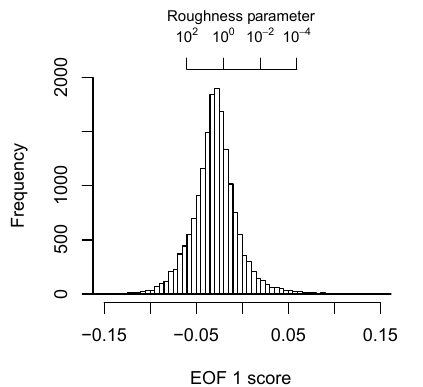
Figure 12. The distribution of EOF 1 scores obtained from cold ice clouds over extratropical oceans during September 2005. The me- dian of the EOF 1 score is − 0.0293, corresponding to a roughness parameter of 2.82. Consistent with previous studies, roughened par- ticles better simulate the measured polarized reflectivity.